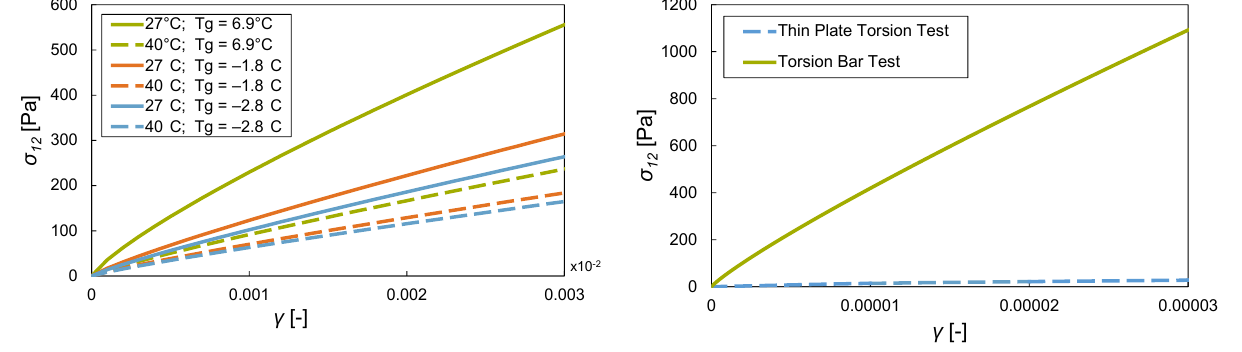
Figure 6: Results – Thin Plate Torsion Test and Torsion Bar Test: longitudinal shear stress σ 12 vs. shear strain 𝛾 at 0.002 s −1